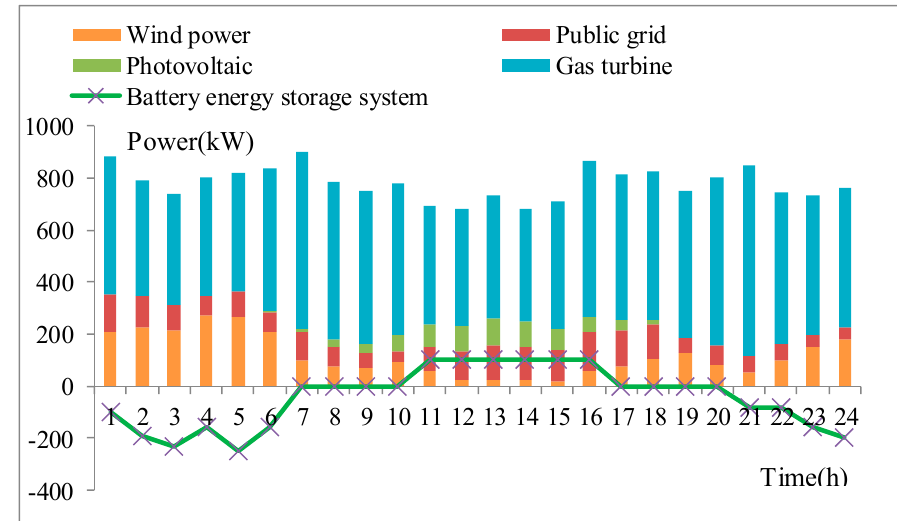
Figure 3. The output structure of each device in Scenario 1.